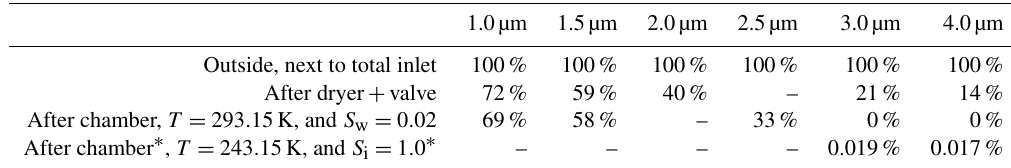
Table A2. Transmission fraction of ambient particles during a Saharan dust event at JFJ on 9 February 2020 over 15min and 6 February 2021 over 190min (marked with ∗